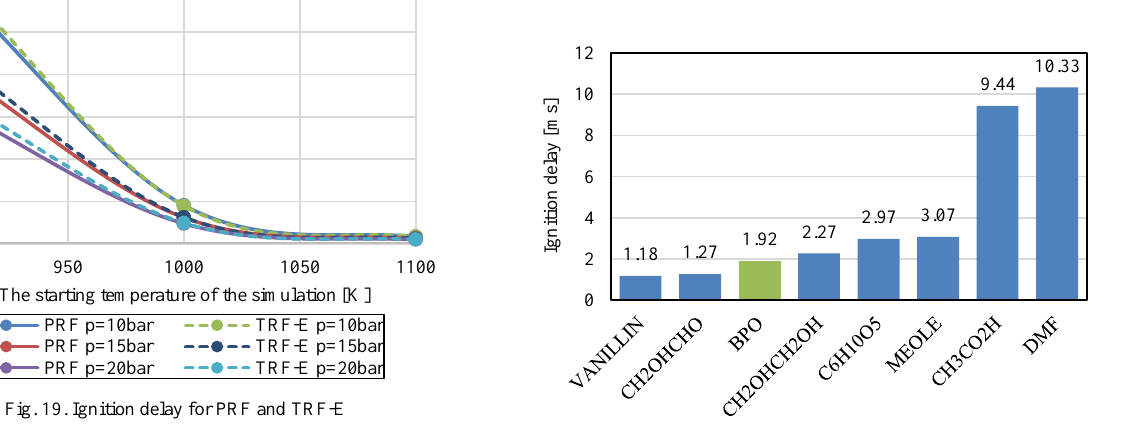
Fig. 20. Ignition delays for research surrogates Comparing the calculated ignition delay with the exper- iment, conclude is that all surrogates except BPO have a delay consistent with the results of the experiment. Oil from biomass pyrolysis should have a longer ignition delay than that of butanol and gasoline supplements, but the simulation results did not confirm this. In an attempt to find the cause of this discrepancy, the ignition delay calculations were performed for the individual components of the BPO surrogate. The simulation results are presented in Fig. 21.